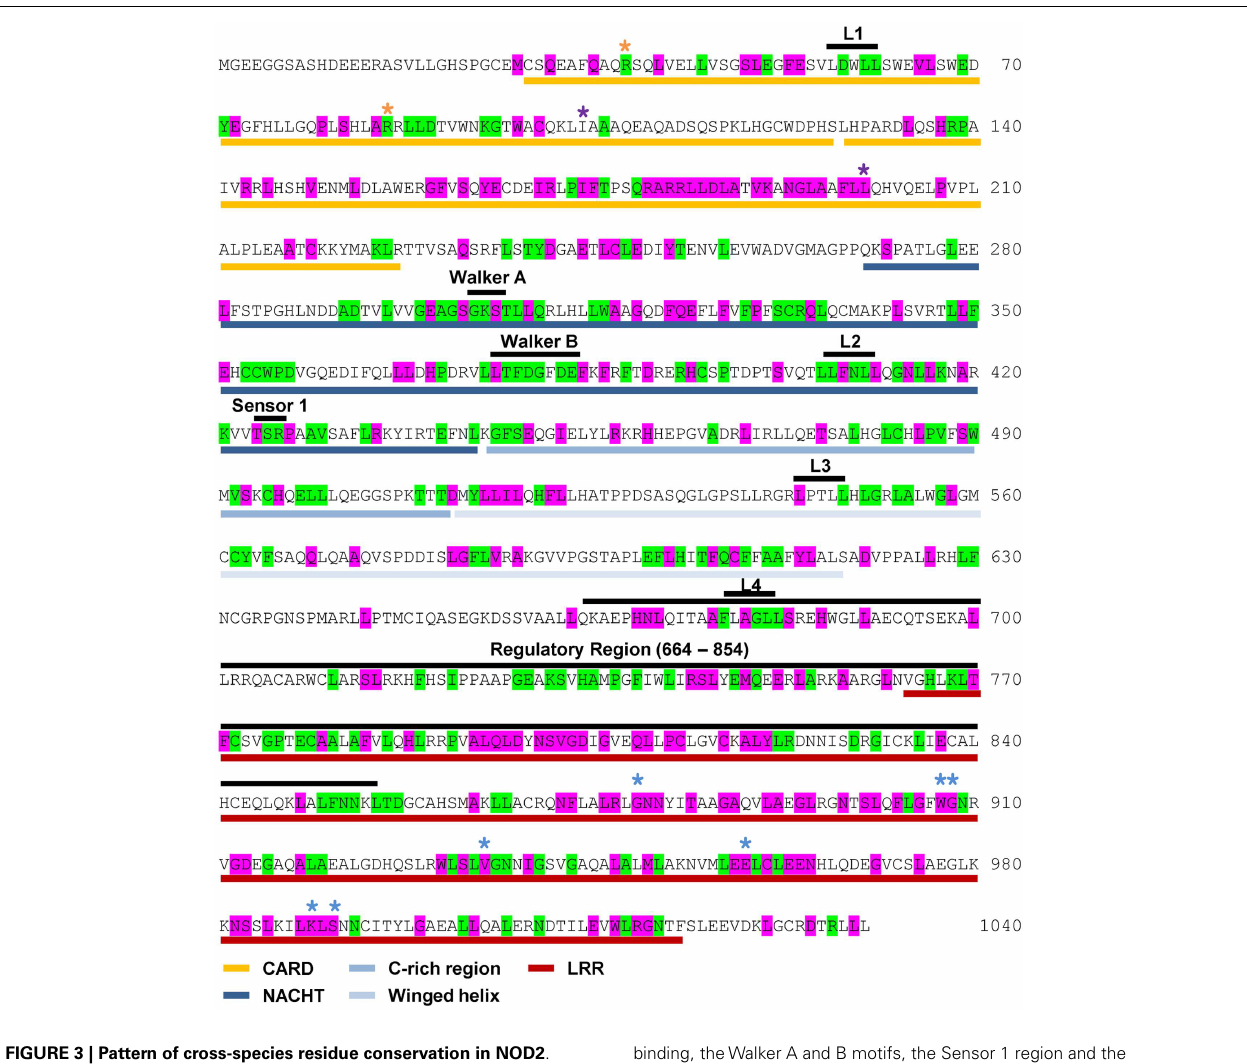
FIGURE 3 | Pattern of cross-species residue conservation in NOD2 . Residues conserved across all NOD2 species checked, or just across mammals, are highlighted green and purple respectively. Residues are mapped onto the amino acid sequence for human NOD2.The domain architecture is highlighted underneath the relevant stretch of sequence as follows: CARDs – gold; NACHT – dark blue; C-rich region – blue; Winged-helix – pale blue; LRRs – red.The motifs responsible for RIP2